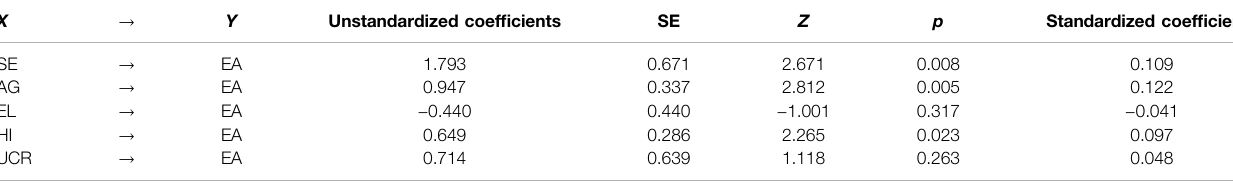
TABLE 5 | Path analysis: demographic variables and environmental awareness.